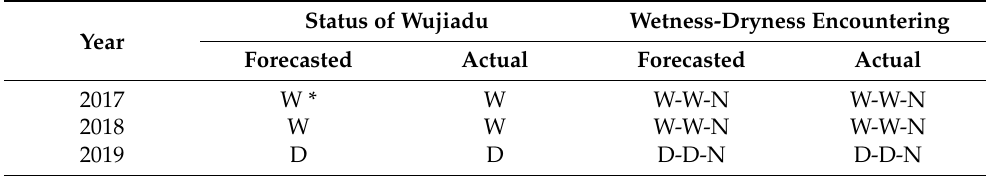
Table 11. The forecasted results and actual statuses from 2017 to 2019. Status of Wujiadu Year